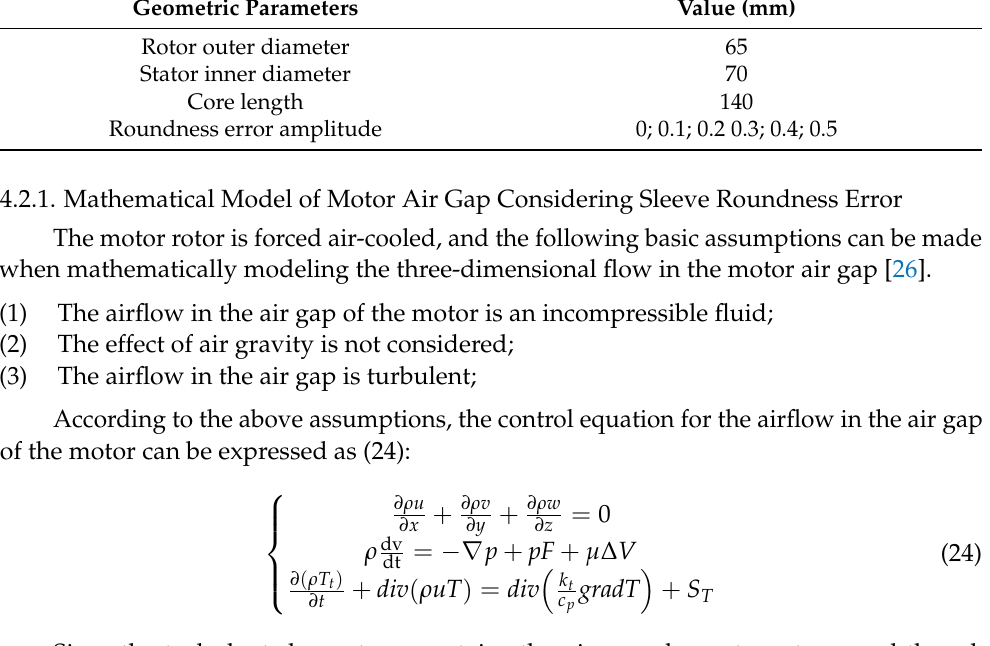
Figure 13. Rotor cross-section with roundness error: ( a ) ellipsoidal; ( b ) trilobed. Table 3. Geometric parameters of the FEM of the rotor.